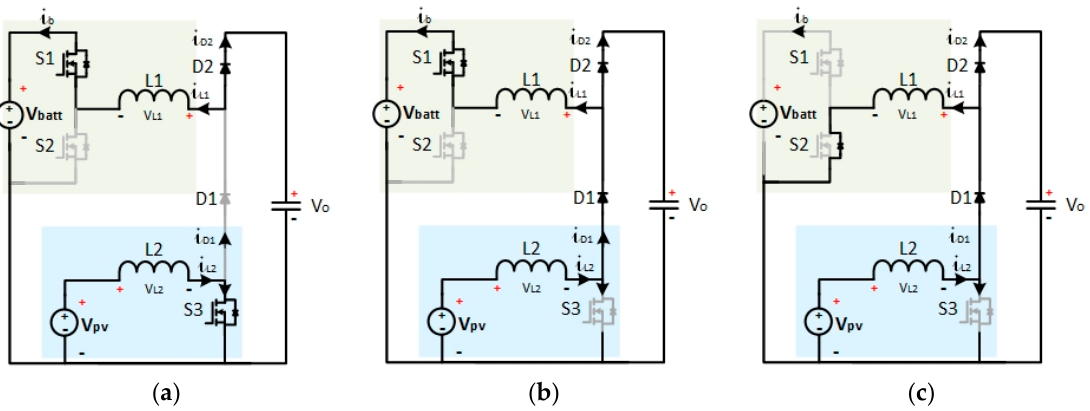
Figure 6. Current flow paths of operating stages in DISO mod: ( a ) Stage I; ( b ) Stage II; ( c ) Stage III.